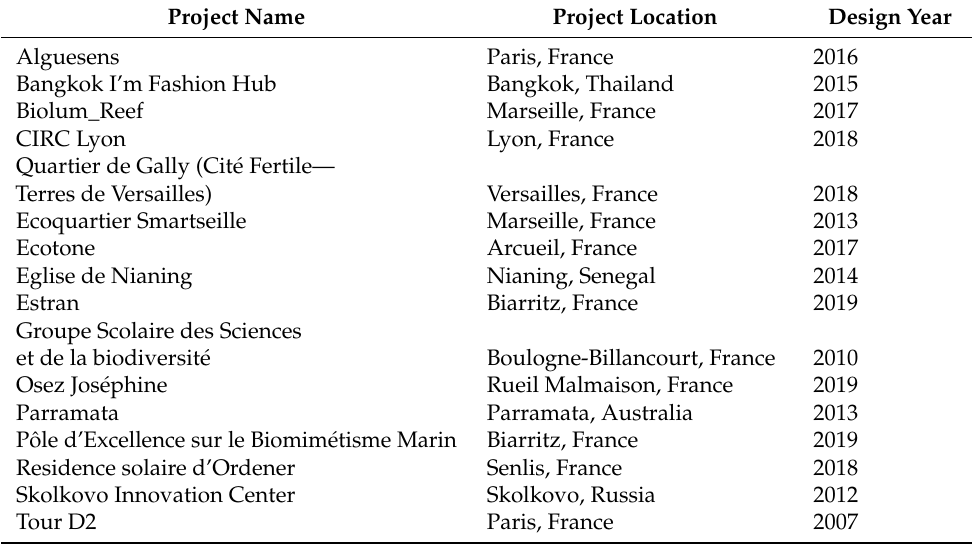
Table 1. Analyzed